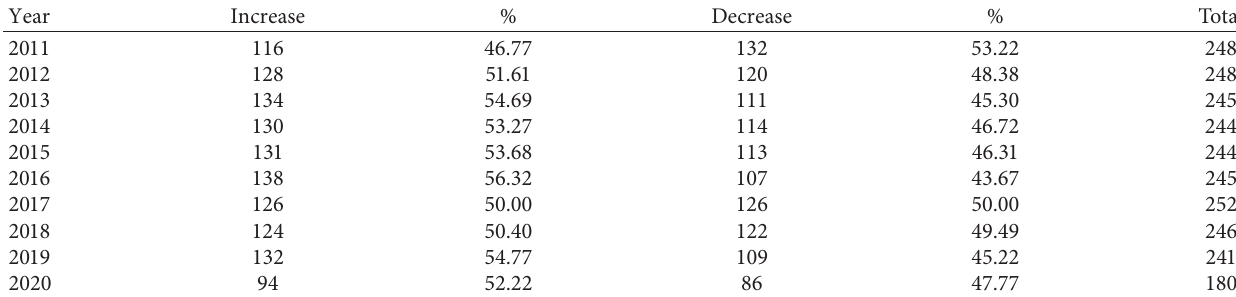
Table 8: Percentage of increase and decrease cases of Nikkei 225.